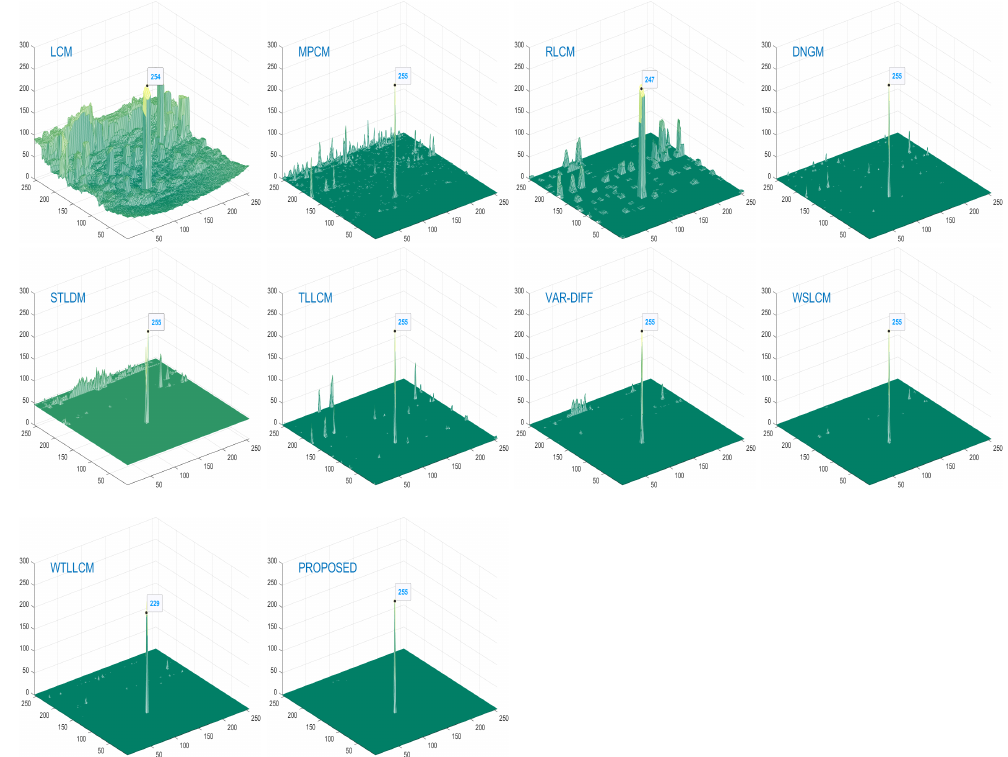
Figure A4. Three-dimensional displays of detection results on one frame in data5. Different subgraphs are the results of different